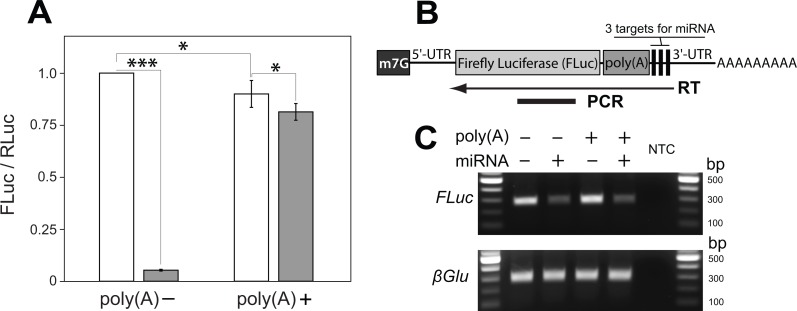
A poly(A) tract placed upstream of miRNA cleavage sites stabilizes the cut transcript.(A) An artificial micro RNA (miRNA) guided cleavage at three complementary sites inserted into the 3′ UTR of Firefly Luciferase (FLuc) transcripts. Renila Luciferase (RLuc) served as a reference control and was expressed from a separate plasmid. The FLuc/RLuc ratio was quantified for two kinds of FLuc transcripts: without and with an internal poly(A) tract of 139 nucleotides inserted upstream of the miRNA targets sites (poly(A)− and poly(A)+, respectively). The miRNA was either absent (white bars) or present (grey bars) in transfected cells. Bars depict mean ± one standard deviation (P < 0.05∗ and P < 0.001∗∗∗). (B–C) RT-PCR was used to analyze the miRNA-guided cleavage of FLuc transcripts. (B) FLuc transcript is depicted with a 7-methylguanosine cap (m7G) and a poly(A) tract internally and at its 3′ end, respectively. To analyze cleavage of FLuc transcripts, a specific primer was used for reverse transcriptase (RT) reaction. The arrow indicates a position and direction of first-strand cDNA synthesis relatively to FLuc PCR amplicon and transcript parts. FLuc RT-PCR amplicons will not amplify from transcripts cut at miRNA target sites. (C) Co-expression of the miRNA substantially decreased FLuc RT-PCR amplification from both kinds of FLuc transcripts, and did not affect levels of polyadenylated β glucuronidase (βGlu) transcripts. No template was added to the last well (NTC).